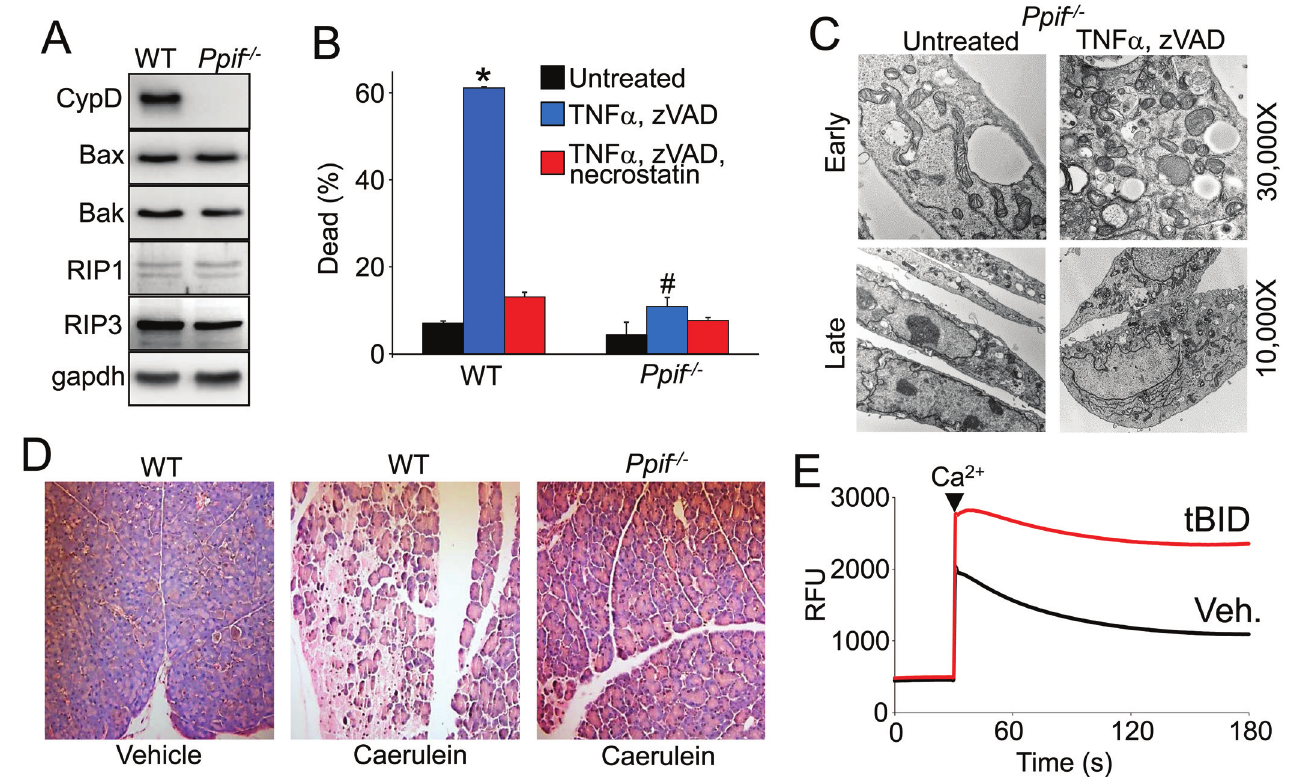
Fig 3. MPTP opening is required for necroptosis. A, Western blots for CypD, Bax, Bak, RIP1, RIP3, and gapdh (control) from extracts of WT and Ppif -/- MEFs. B, Quantitation of dead cells in WT and Ppif -/- MEFs treated with TNF α and zVAD-FMK with and without necrostatin. All assays were performed in duplicate and averaged from three independent experiments. * p < 0.01 vs untreated; # p < 0.01vs WT treated. C, Transmission electron microscopy in Ppif -/- MEFs treated with and without TNF α and zVAD-FMK for 2 hours (Early) and 12 hours (Late) at 2 different magnifications. D, Images of pancreas stained with H&E from WT and Ppif -/- mice treated with caerulein to induce necroptosis-mediated pancreatitis (200X magnification). E, Calcium uptake capacity assay with membrane impermeable calcium indicator dye Calcium Green-5N in purified mitochondria from WT liver pretreated with tBID (red) or vehicle (black). The calcium addition is labeled with an arrowhead. Fluorescence reduces as the mitochondria take up the calcium from the solution; three independent experiments were performed, although a representative trace is